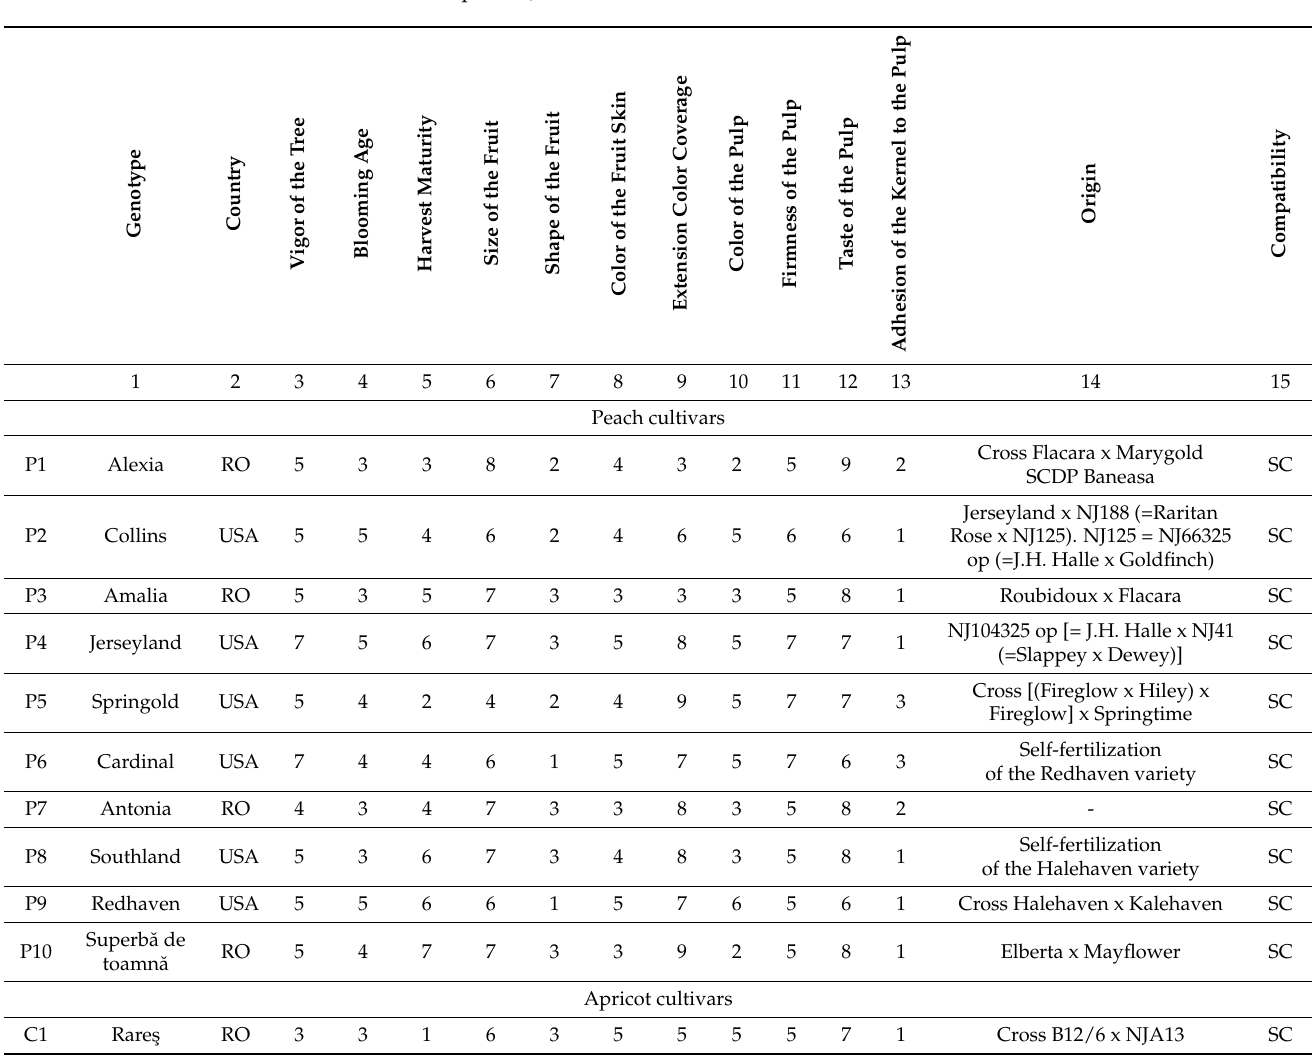
Table 1. Characterization of apricot, peach and nectarine cultivars according to descriptors used in the genus Prunus : 1. Genotype; 2. Country; 3. Vigor of the tree (1. very small; 3. small; 5. medium; 7. great; 9. very great); 4. Blooming (1. extremely early; 2. very early; 3. early; 5. intermediate; 7. late; 8. very slow; 9. extremely late); 5. Harvest time (1. extremely early; 2. very early; 3. early; 5. average season; 7. late; 8. very slow; 9. extremely late); 6. Size of the fruit (1. very small (<20 g); 3. small (21–30 g); 5. medium (31–40 g); 7 great (41–50 g); 8. very big (51–60 g); 9. extremely big (>60 g); 7. Shape of the fruit (Apricot: 1. spherical; 3. ovoid; 5. cordiforme; 6. ovo-conical; 7. oblong; 9. elliptical. Peach: 1. very flat; 2. slightly flattened; 3. ovoid; 4. cordiforme; 5. oblong, 6. elongated); 8. Color of the fruit skin (Apricot: 1. greenish yellowish; 2. open cream; 3. cream; 4. yellow; 5. open orange; 6. orange; 7. dark orange. Peach: 1. green; 2. yellowish green; 3. cream; 4. yellowish cream; 5. yellow; 6. open orange); 9. Extension color coverage (Apricot: 1. absence; 3. reduced; 5. medium expansion; 7. widely extended. Peach: 1. absent; 2. red trail; 3. red stripe; 5. partially red; 6. red extended; 7. red; 8. bright red); 10. Color of the pulp (Apricot: 1. yellowish green; 2. yellowish white; 3. cream; 4. cream; 5. yellow; 6. opened orange; 7. orange; 8. dark orange; 9. Red. Peach: 1. greenish white; 2. white; 3. white yellowish; 4. yellowish; 5. yellow; 6. yellow orange; 7. orange; 8. red); 11. Firmness of the pulp (1. extremely soft; 3. soft; 5. medium; 7. firm; 9. very firm); 12. Taste of the pulp (1. very poor; 3. lower; 5. mediocre; 7. good; 9. excellent); 13. Adhesion of the kernel to the pulp (1. nonadherent; 2. semiadherent; 3. adherent); 14. Origin; 15. Compatibility (SI–Self-incompatible; SC–Self-Compatible).